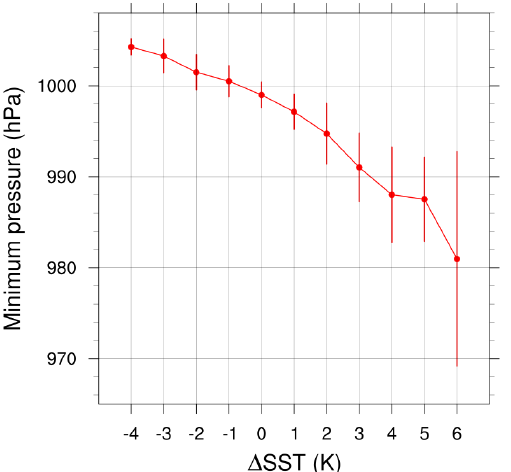
Figure 5. Dependence of composite minimum pressure on SST change. The error bars represent standard deviation.